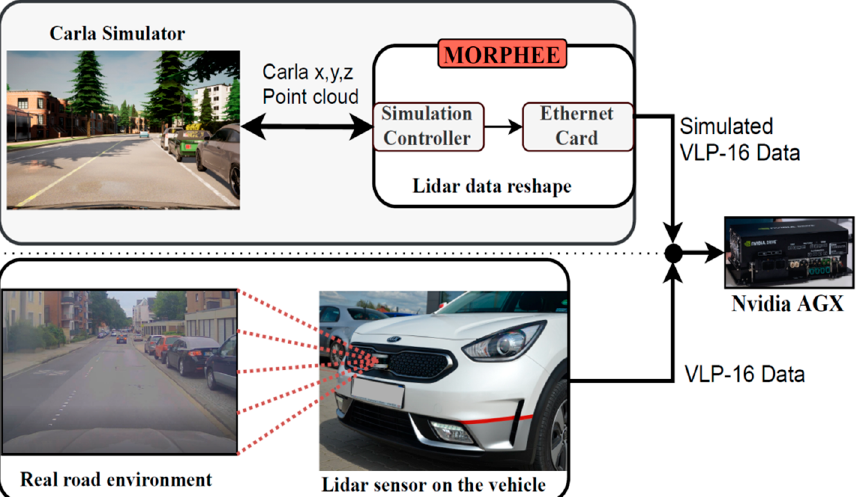
Figure 18. Data flow diagram of VLP-16 lidar simulation for free space detection algorithm and standard flow of data for real hardware lidar in vehicle.